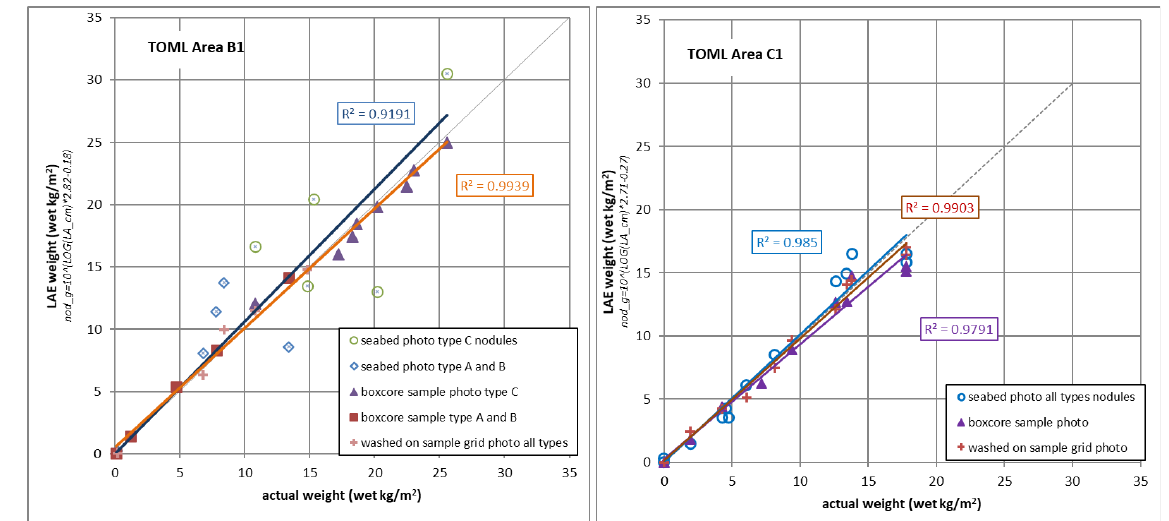
Figure 19. Correlations between total long-axis lengths and nodule sample weights, TOML areas B1 and C1. Source: Lipton et al. [12]; total sample weights and measurements were used for reasons of accuracy. Seabed photographs were taken from the box-core sampler immediately prior to landing; box-core sample photographs were taken of the undisturbed samples after landing the sampler back on the expedition vessel. Grid photo measurements are from nodules on a sample display grid after collection from the box core and washing and weighing. For TOML Area B1, the samples were also classified using a local nodule facies system to see if there was a discernible difference in the relationship. A type nodules are mostly small nodules, B type nodules are of mixed sizes, and C type nodules are mostly large nodules.